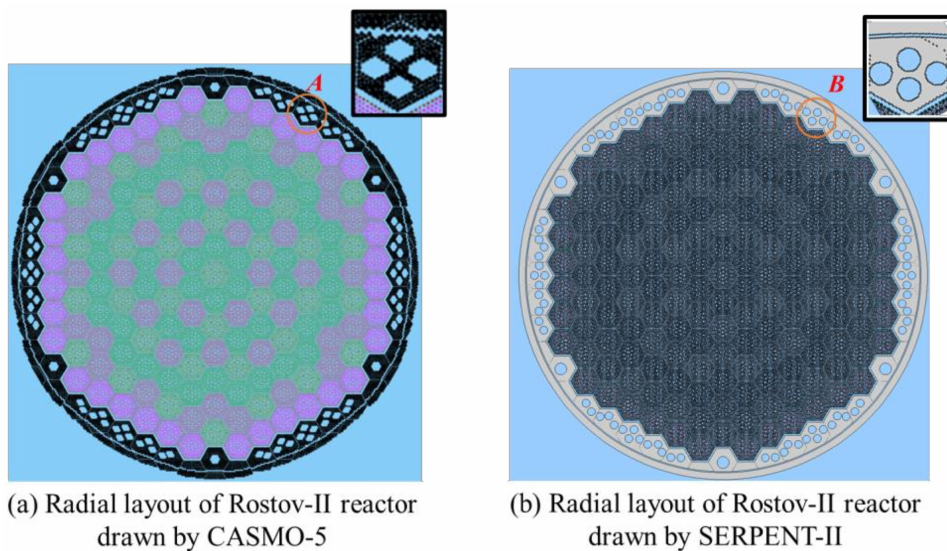
Figure 16. Radial layout of the nominal and simplified reflector model.